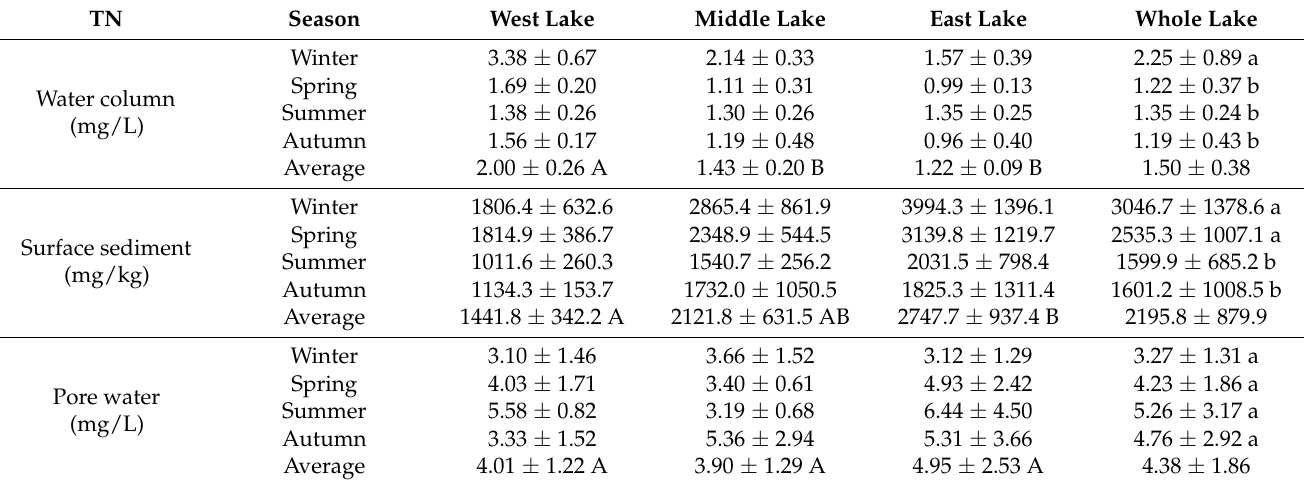
Table 2. The averages and standard deviation (SD) of TN concentrations in different seasons of the water column, surface sediment, and pore water in Lake Yangcheng. Different letters represent statistically significant differences according to Fisher’s PLSD test ( p < 0.05). Upper case letters (row): among different areas (west, middle, and east); lower case letters (column): among different seasons (winter, spring, summer, and